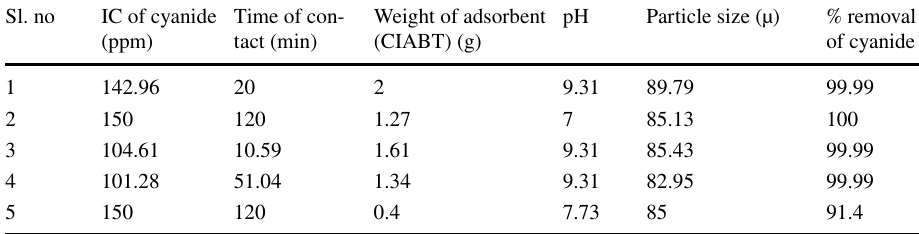
responses with corresponding operating parameters obtained by particle swarm optimization (PSO) for the removal of